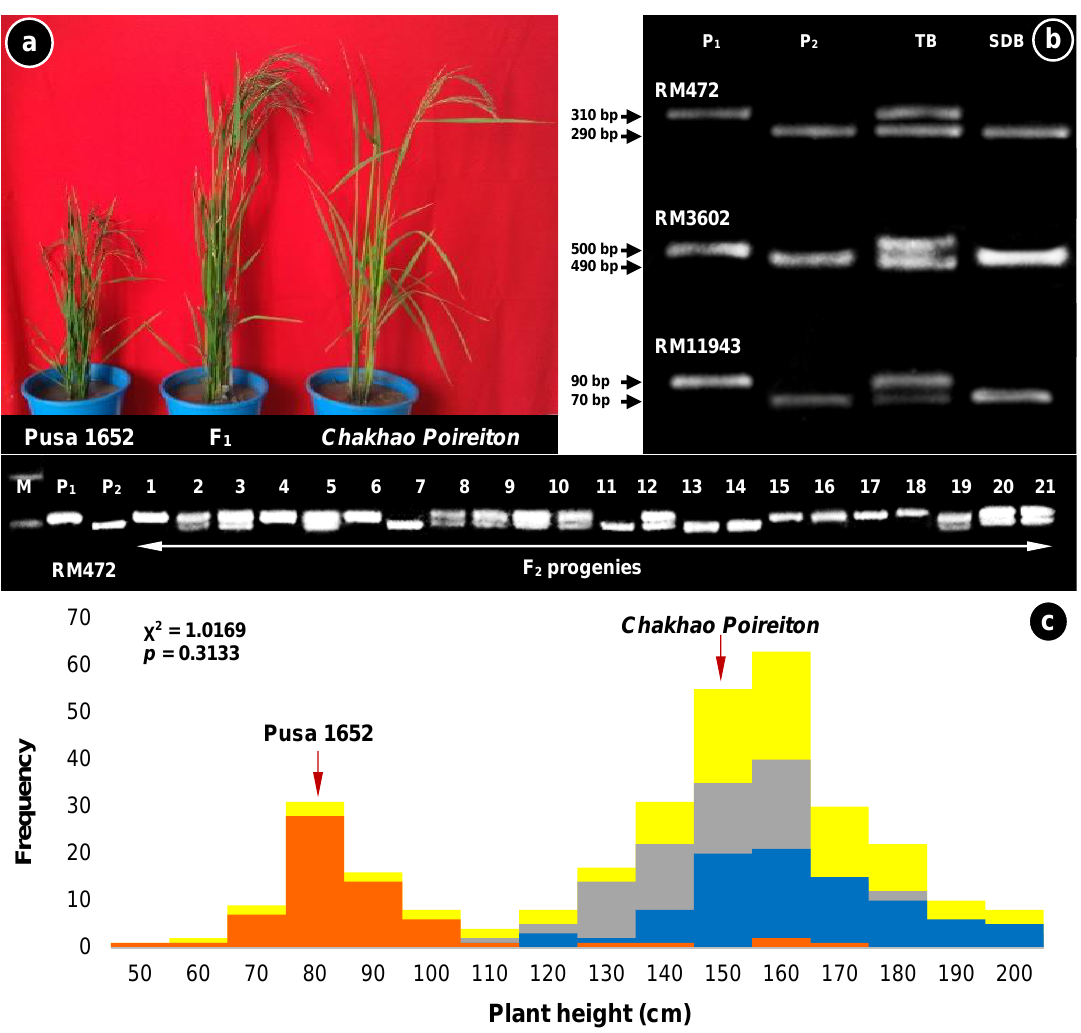
Figure 1. ( a ) Representative photograph showing the differences in plant height of the parents, Pusa 1652 (semi-dwarf), F 1 (tall) and Chakhao Poireiton (tall); ( b ) amplification profile of three putatively linked markers identified through Bulked Segregant Analysis. P 1 — Chakhao Poireiton , P 2 — Pusa 1652, TB — tall bulk, SDB — semi-dwarf bulk. TB and SDB represent 10 tall plants and 10 semi-dwarf plants, respectively, in the F 2 population from the cross, Pusa 1652/ Chakhao Poireiton ; ( c ) frequency distribution of plant height among the F 2 segregants possessing Pusa 1652 allele (orange), Chakhao Poireiton allele (blue) and heterozygotes (grey) based on the RM472 marker. The yellow bars indicate the overall frequency distribution of F 2 plants. A representative amplification profile of RM472 in the F 2 generation is placed above the graph, M indicates the 100 bp ladder.